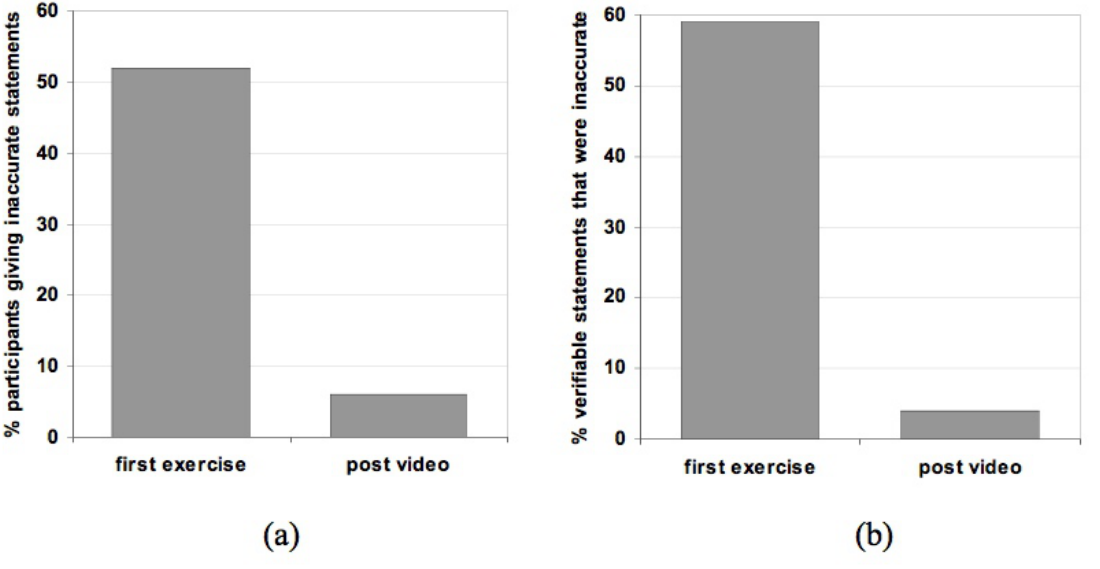
Figure 2. (a) Percentage of students who gave inaccurate statements in the first exercise and after the video; (b) percentage of inaccurate statements